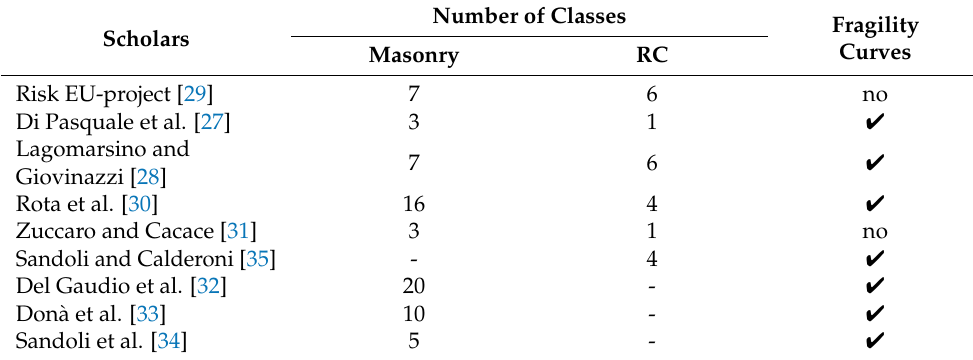
Table 2. Typological classifications of existing buildings in